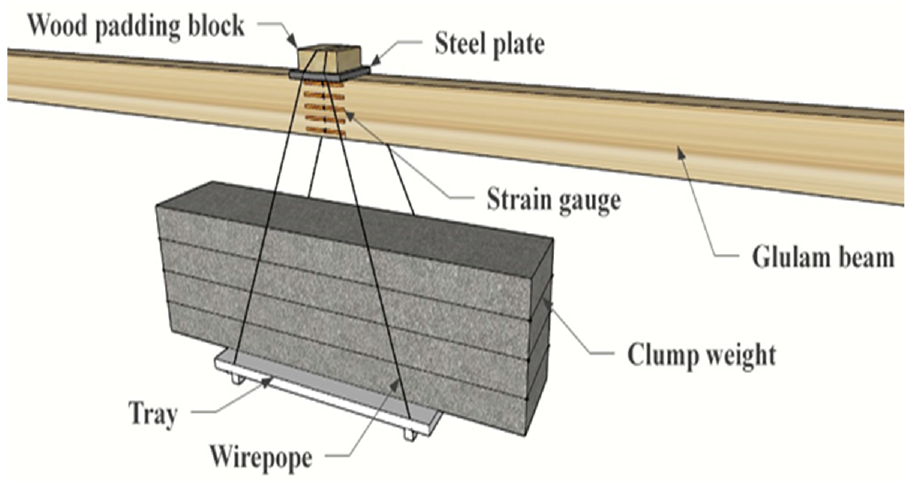
Figure 4. Loading method.